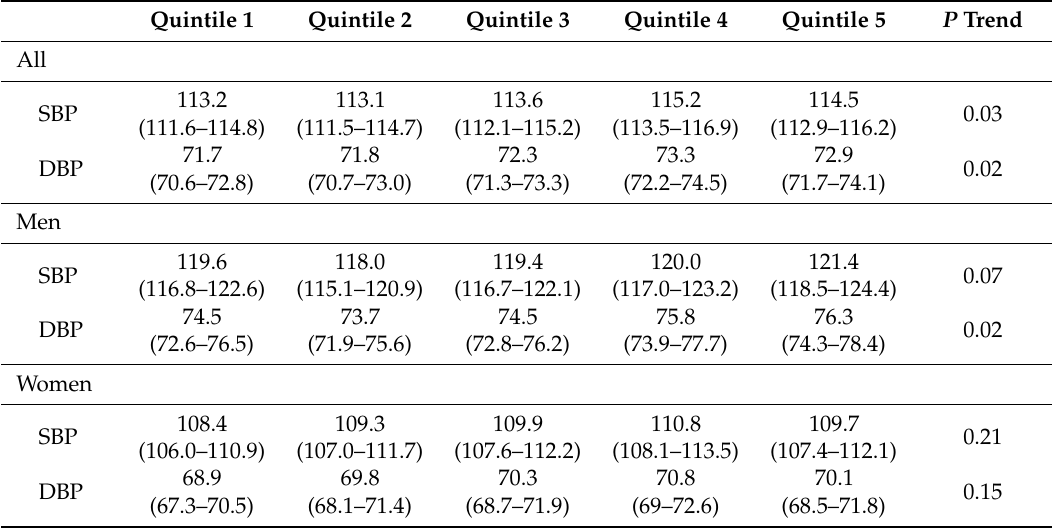
Table 5. Multivariate-adjusted geometric means (95% CIs) 1 of systolic and diastolic blood pressures (mmHg) according to sodium-contributing food score.